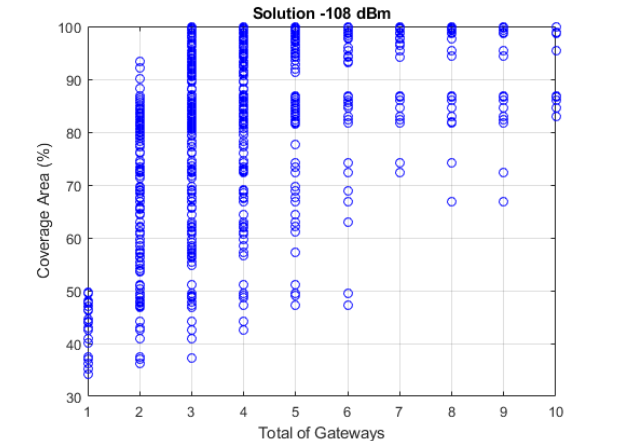
Figure 10. Solutions for − 108 dBm